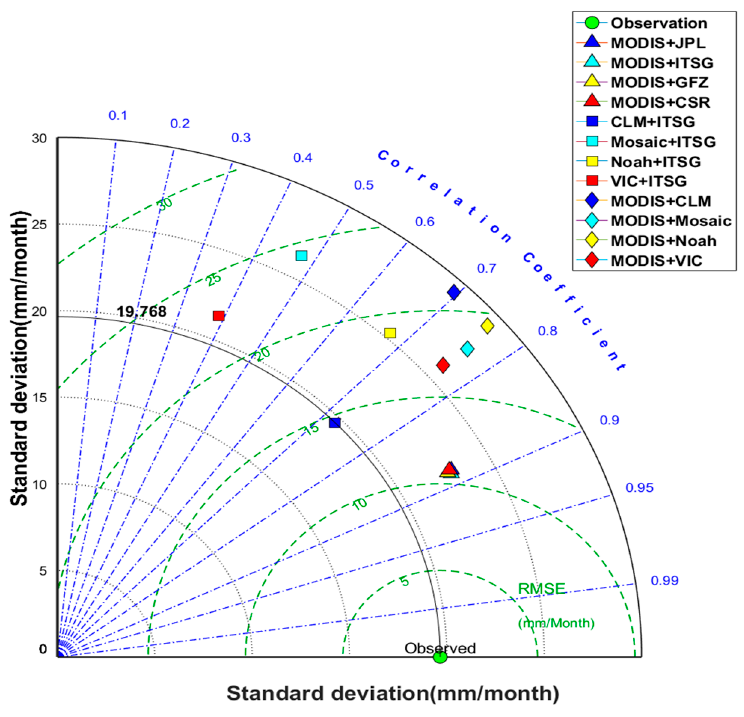
Figure 8. Taylor’s diagram showing the statistics results obtained from the comparison between the observed (green circle) and remotely sensed runoff in the Yangtze River Basin (derived from the MODIS evapotranspiration and several GRACE terrestrial water storage (triangles), several GLDAS evapotranspiration and ITSG GRACE terrestrial water storage (squares), and the MODIS evapotranspiration and several GLDAS water storage (diamonds) data.